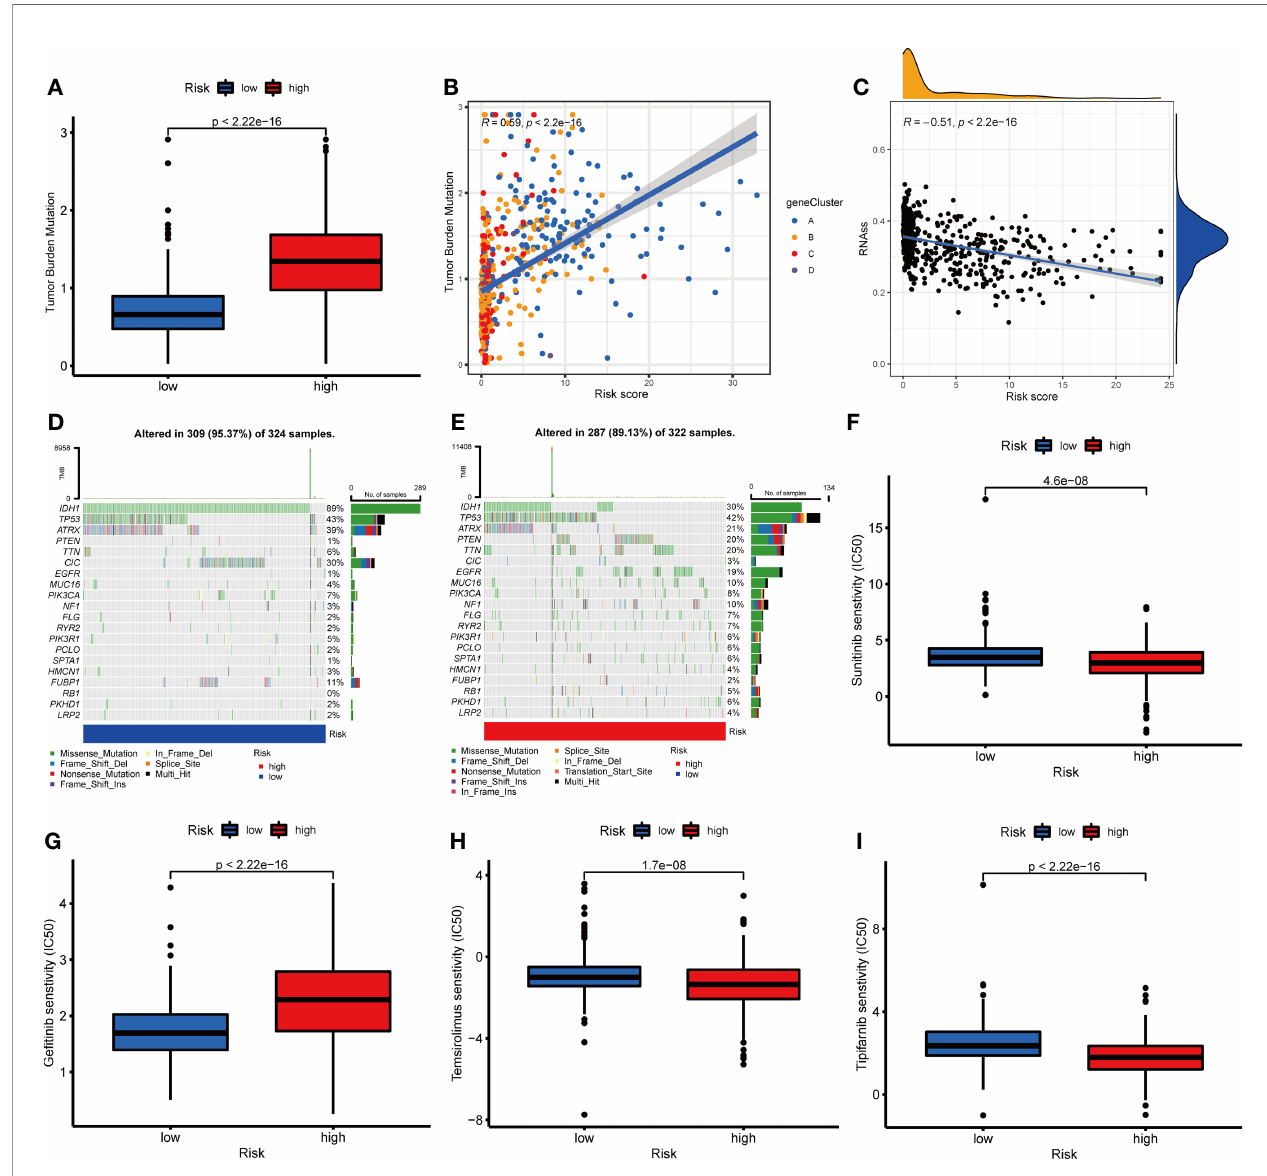
FIGURE 11 | Correlation between NRG_score and mutation, CSC index, and drug sensitivity. (A) Comparison of TMB in two risk groups. (B) Spearman correlation analysis between TMB and the NRG_score. (C) Spearman correlation analysis between CSC index and the NRG_score. (D, E) The waterfall plot of somatic mutation features in the low- (D) and high-risk (E) groups. (F – I) Comparison of chemotherapy sensitivity in glioma between two risk